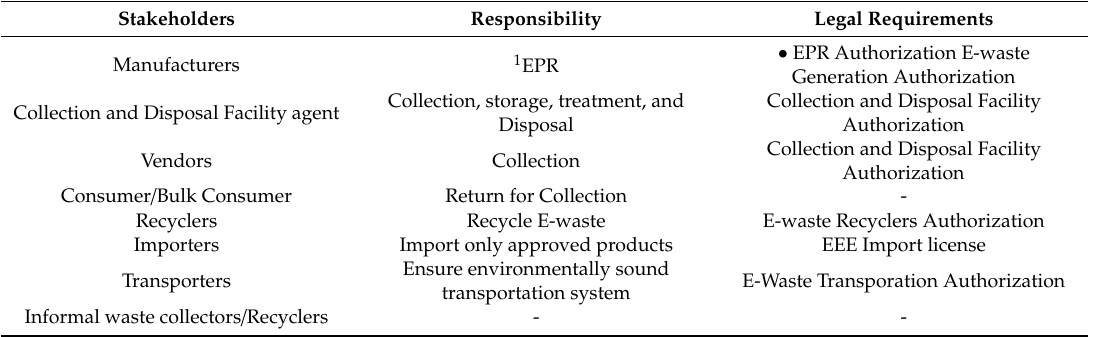
Table 2. The components of Nigerian Communications Commission (NCC) Policy Guidelines on E-waste Management in Nigeria. Source